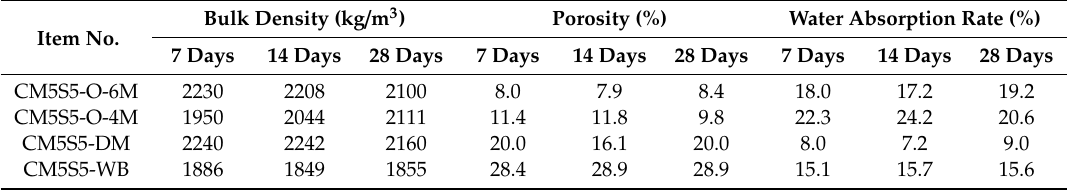
Table 9. Test results of the bulk density, porosity and water absorption rate of marble-based geopolymer concrete.